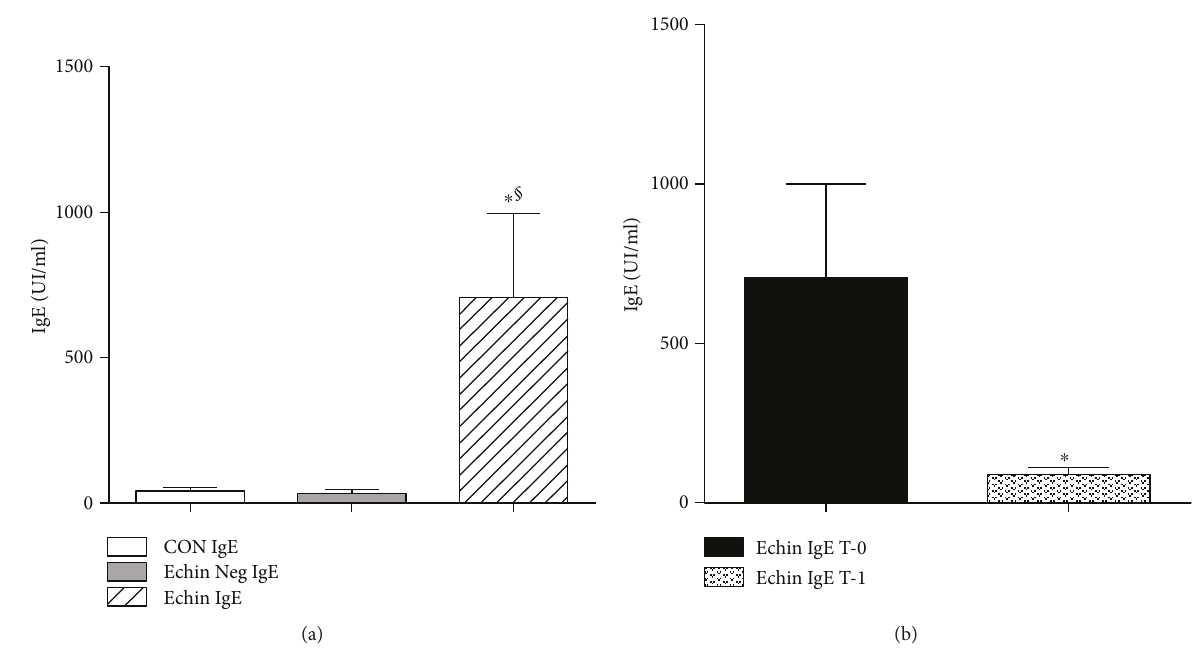
Figure 8: (a) Serum levels of IgE in the group of infected patients showed a signi fi cant increase ( p < 0 05 ) compared to corresponding serum concentrations found in healthy controls and Echinococcus -negative patients. Values are expressed as mean ± SEM ∗ p < 0 05 versus CON; § p < 0 05 versus Echin Neg, after ANOVA and Fisher PLSD test. (b) A signi fi cant decline in the concentrations of levels of IgE in parasite-infected patients one week after surgery (time T-1) ( p < 0 05 ) compared with the levels found in patients before any therapy (time T-0). ∗ p < 0 05 versus Echin IgE T-0, after ANOVA and Fisher PLSD